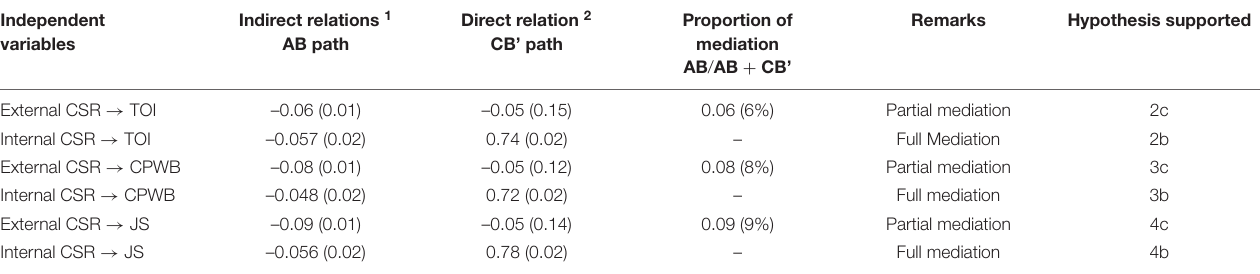
TABLE 6 | Mediation of Job satisfaction between CSR Dimensions and Employee work behaviors. Independent